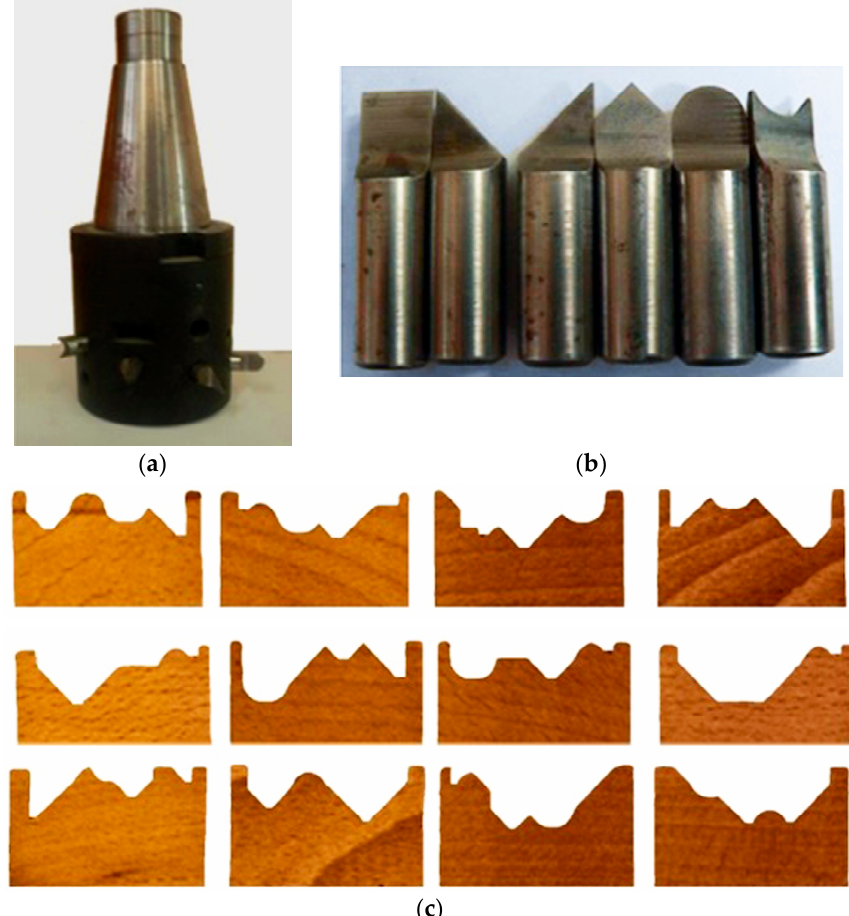
Figure 6. View of ( a ) the multi-insert cutter prototype and ( b ) the inserts (geometry of the cutting edge for each part from left to right (axial feed): k r = 90°, k r = 45°, k r = 45°, k r / = 45°, ε r = 90°, k r // = 45°, r ε = 5 mm, and r ε = − 5 mm); ( c ) examples of 12 shaped surfaces machined with the proposed universal multi-insert profile-cutter.